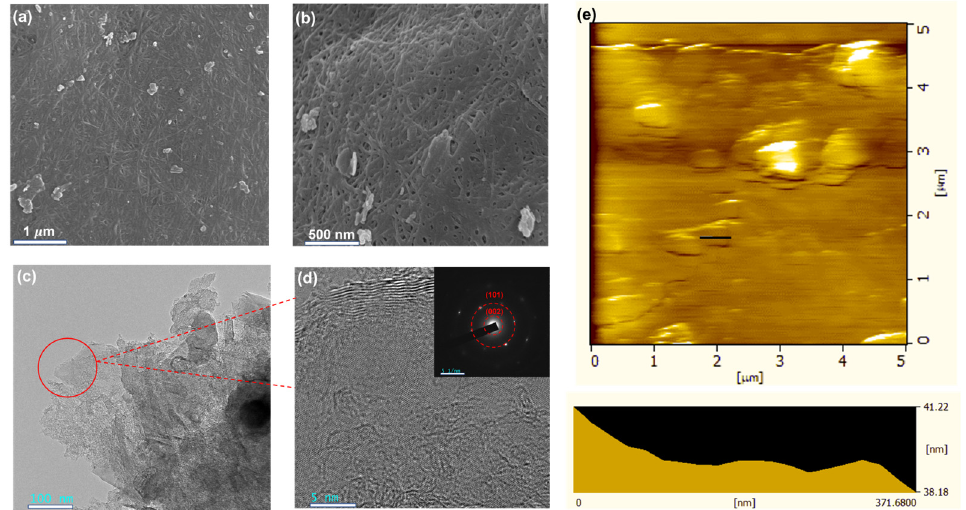
Figure 2. ( a , b ) SEM morphology of CBC/LEGr-I; ( c , d ) TEM and SAED pattern images of CBC/LEGr- I; ( e ) AFM images and corresponding height profiles of BC/LEGr-I taken along the lines are shown in the insets.